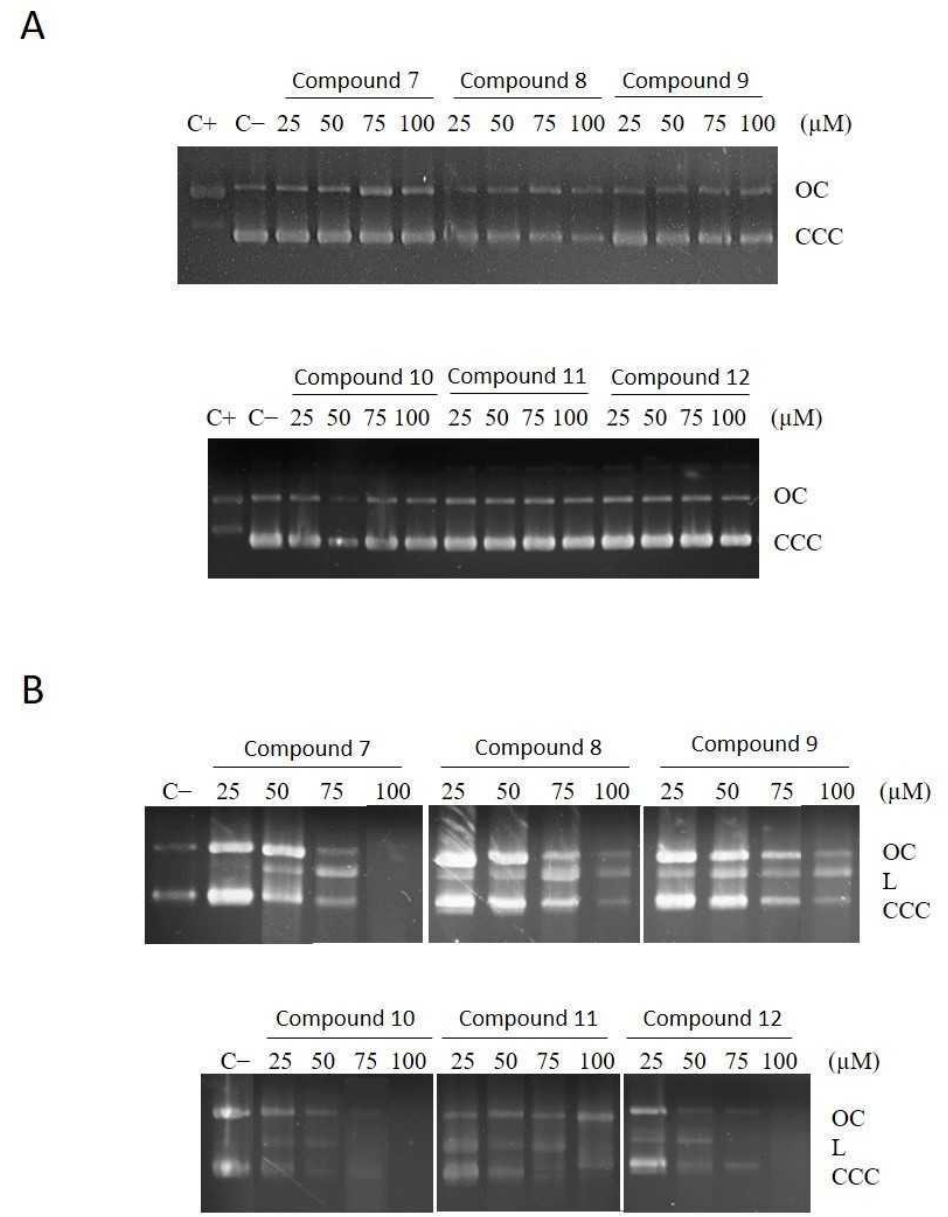
Figure 1. Agarose gel electrophoresis of plasmid DNA (pUC18) treated with the indicated concentra- tions ( µ M) of all the iron compounds in the absence ( A ) and presence ( B ) of H 2 O 2 . Positive control (C+) corresponds to cisplatin and negative control (C − ) corresponds to pUC18 alone. OC = open circular form; CCC = covalently closed circular form; L = linear